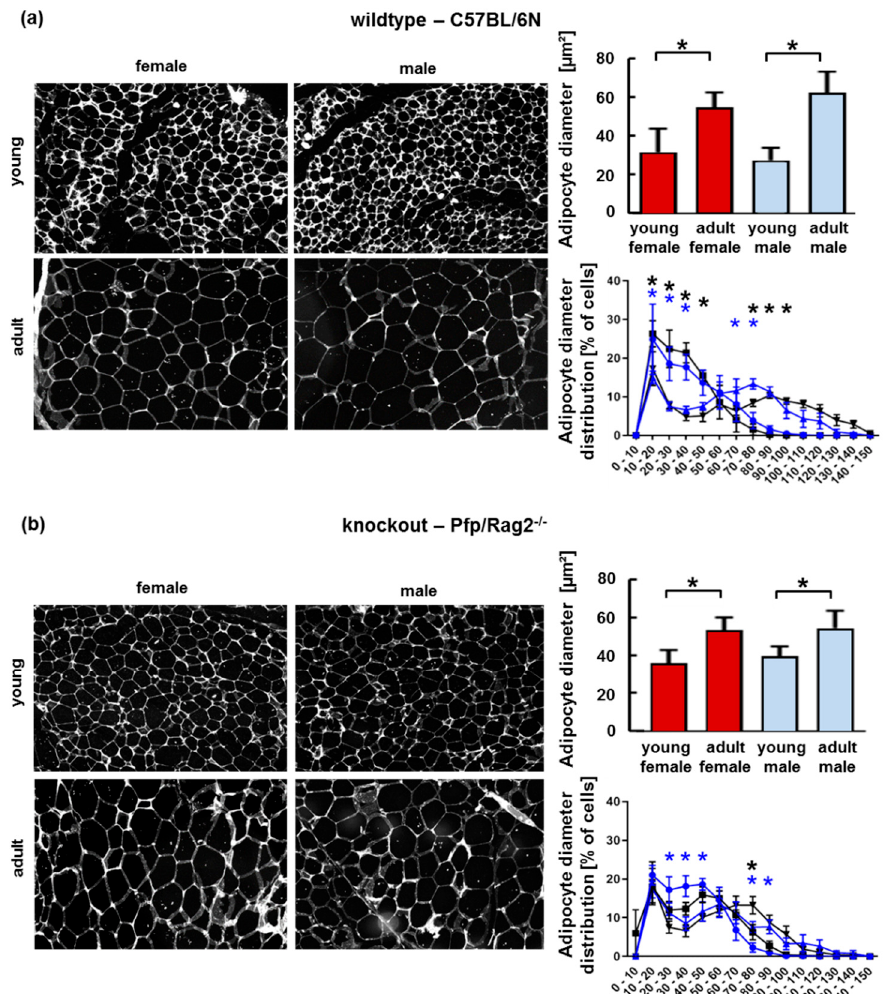
Figure 2. Features of VAT from wildtype and knockout female and male mice. HE staining of adipose tissue revealed larger adipocytes in adult as compared to young animals ( a , b —left panels; shown as binary images (b/w) as used for quantitative analysis). Adipocyte size was quantified by measuring the average diameter of cells from female (red, bold shade) and male (blue, light shade) mice (right: upper panels). Size distribution is shown in the lower right panels. Female mice: young—dots, adult—upward triangles. Male mice: young—squares, adult—downward triangles. Light (blue, female) or bold (black, male) asterisks, resp., indicate significant differences at the p ≤ 0.05 level. Histological pictures in ( a ) and ( b ) are representative of 3 different animals in each group.